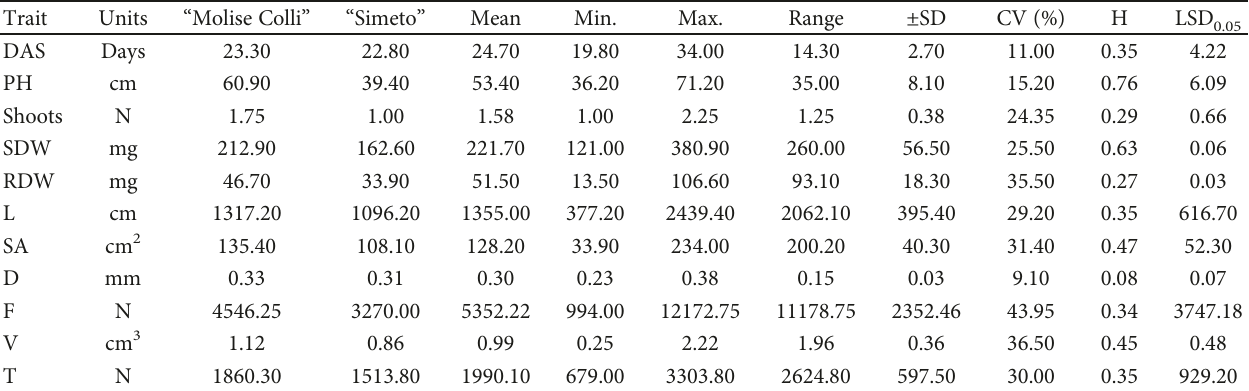
Table 2: Phenotypic variations among the parental lines and RILs from the “ Simeto ” × “ Molise Colli ” population for the shoot and root traits. Trait Units “ Molise Colli ” “ Simeto ” Mean